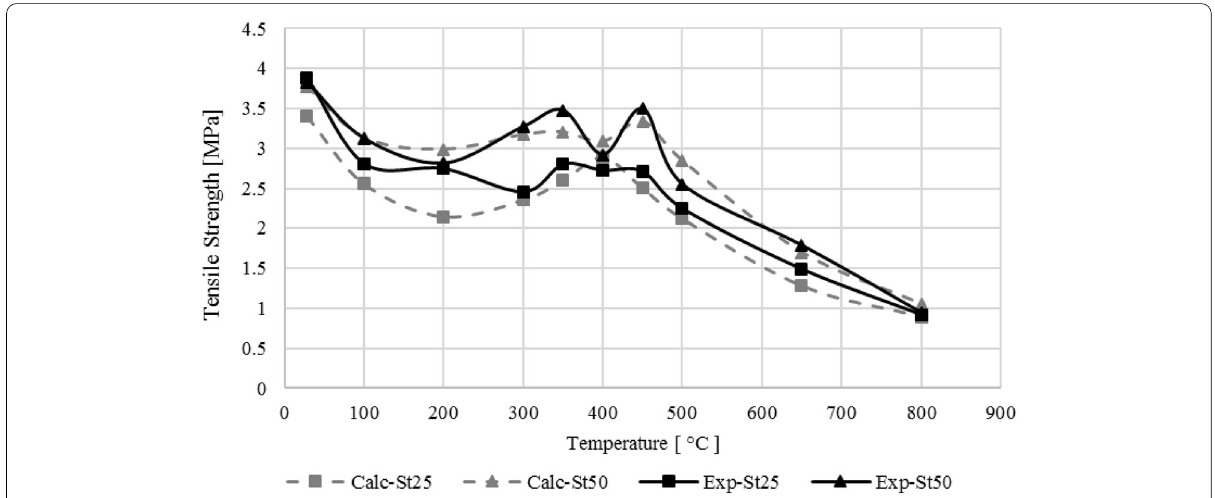
Fig. 11 Comparison between the predicted tensile strength using Eq. 10 and experimental values.